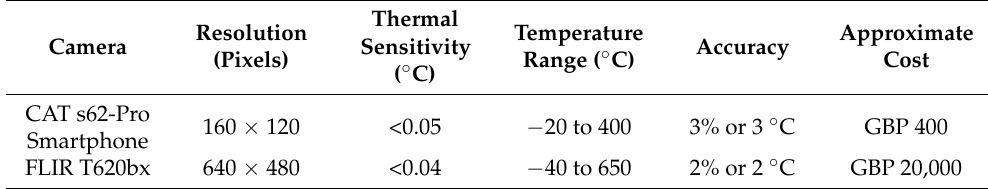
Table 1. Thermal resolution, sensitivity, range, accuracy, and approximate cost of both the CAT s62 Pro Smartphone (LCD) and the FLIR T620bx